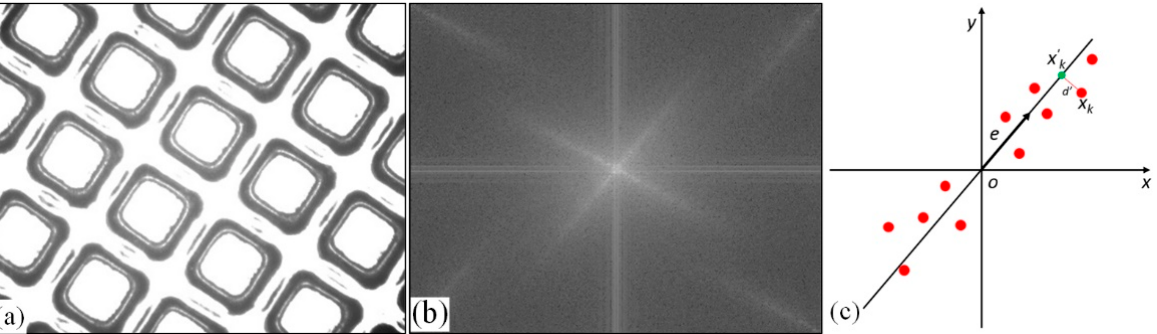
Figure 6. Wafer alignment. ( a ) Rotational wafer image; ( b ) amplitude spectrum; ( c ) discrete points fitting schematic.